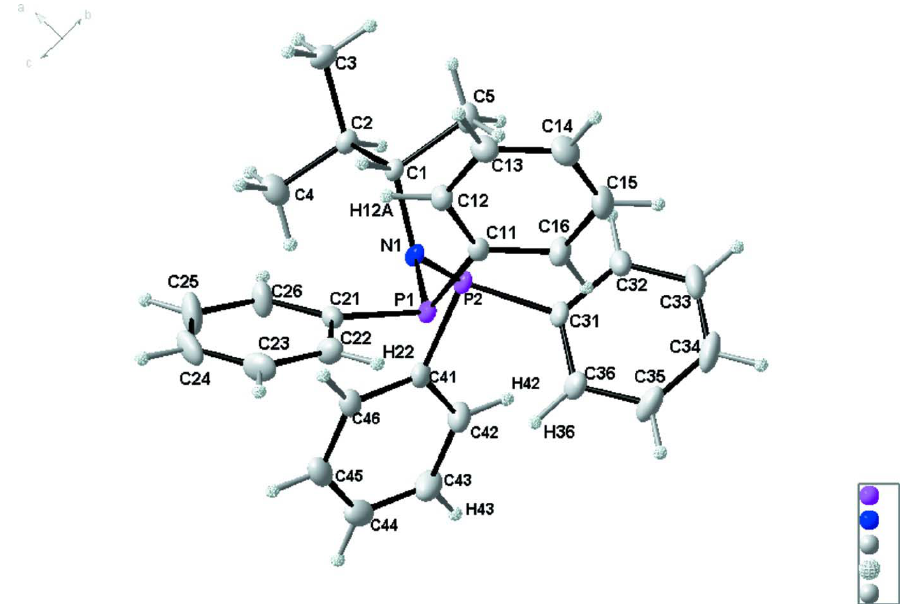
Figure 1 A view of (I) shown with 50% probability displacement ellipsoids. Atoms C1′, C2′ and C3′ and the H atoms have been omitted for